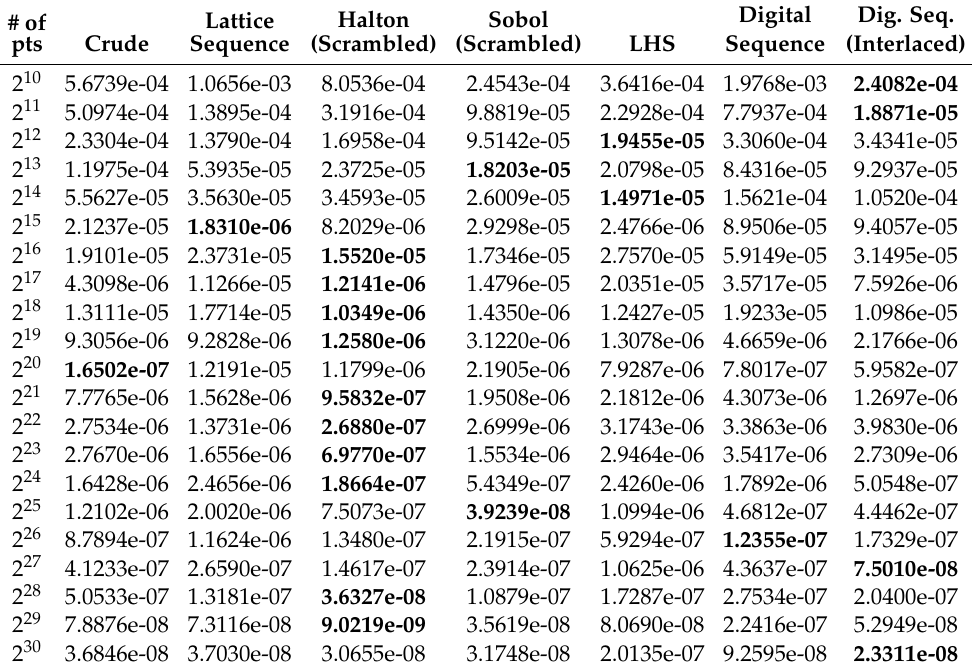
Table 3. The 30-dimensional integral absolute errors. # of pts Crude